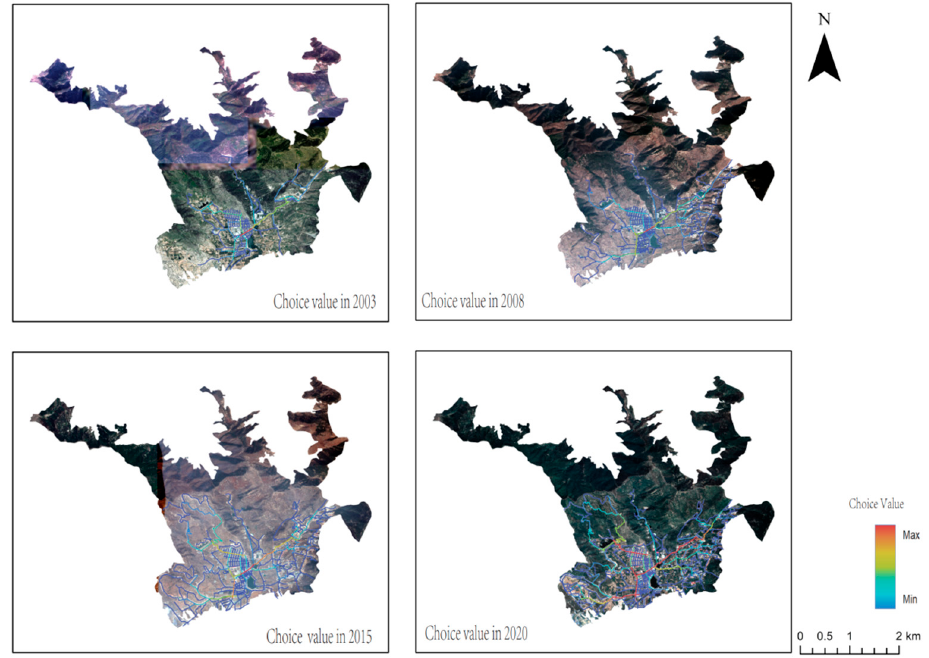
Figure 5. Evolution Process of spatial Choice Value in Matao Village.